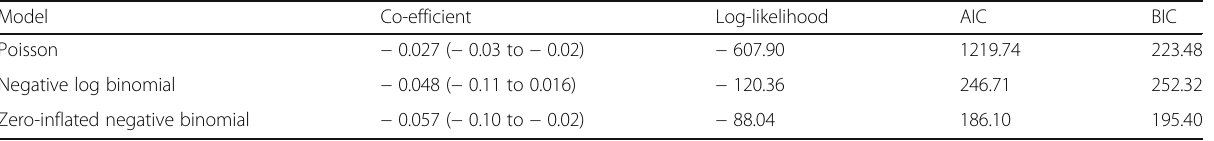
Table 3 Model parameters including the model coefficient and its confidence intervals for various count models used in prediction of KFD cases in Goa 2015 –